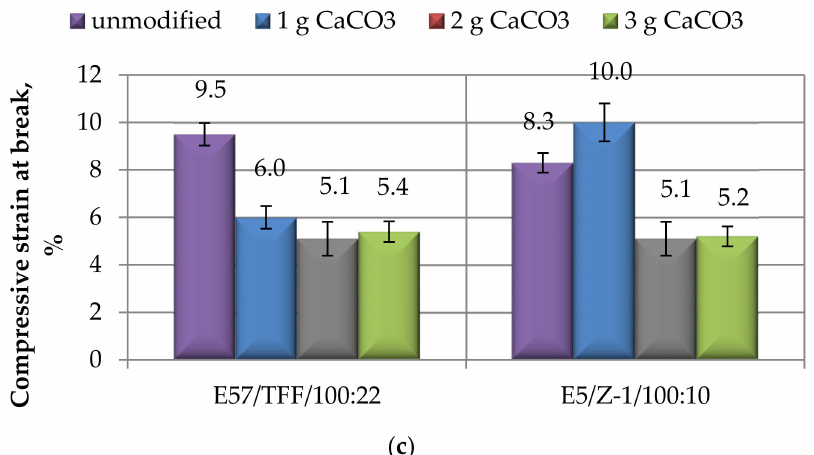
Figure 2. Results of mechanical tests performed in compression mode on unfilled and CaCO 3 - filled specimens, tested before any aging procedure, based on E57/TFF/100:22 and E57/Z-1/100:10 systems, respectively, in terms of: ( a ) Compressive modulus; ( b ) Compressive maximum strength; ( c ) Compressive strain at